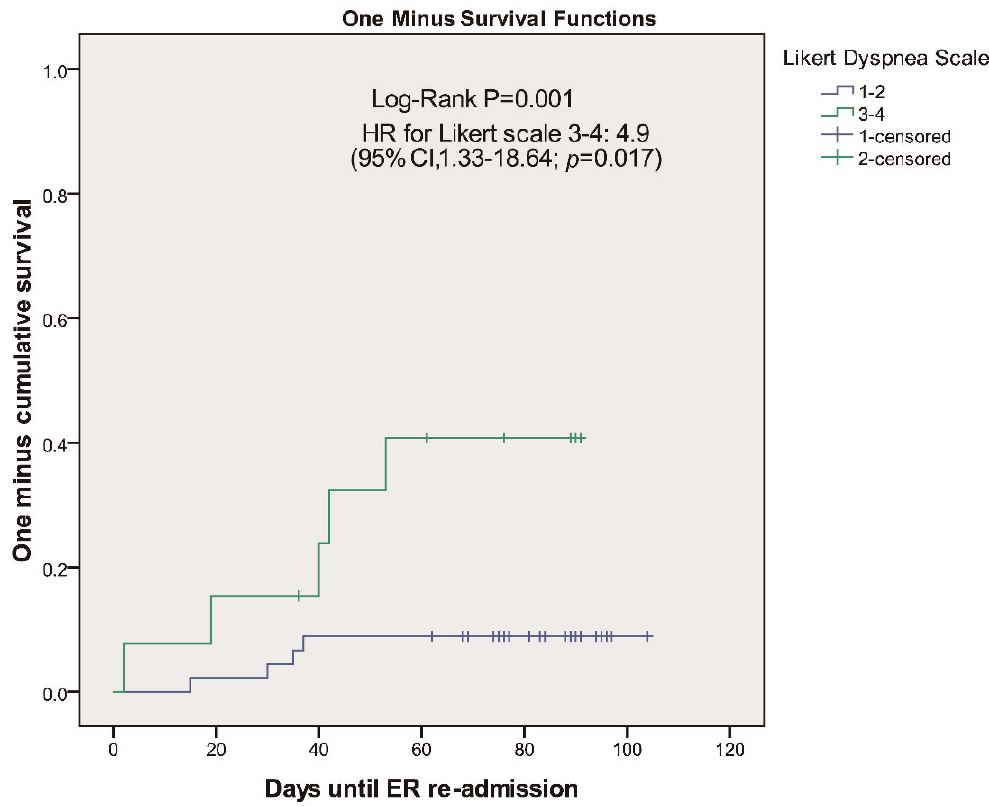
Figure 3 - Kaplan-Meier 1-cumulative survival curve for the emergency room admission of patients stratified into two groups based on the 5-point Likert scale for dyspnea: patients with scores of 1-2 and patients with scores of